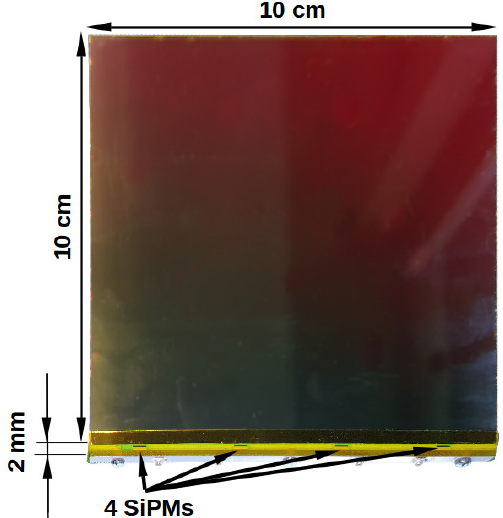
Figure 1. ArgonCube Light (ArCLight) 10 × 10 cm 2 prototype. Four silicon photomultipliers (SiPMs) in surface mount device (SMD) packages can be seen at the lower side, soldered to a narrow printed circuit board (PCB) which provides SMD coaxial connectors for signal readout. The rest of the sensor area is